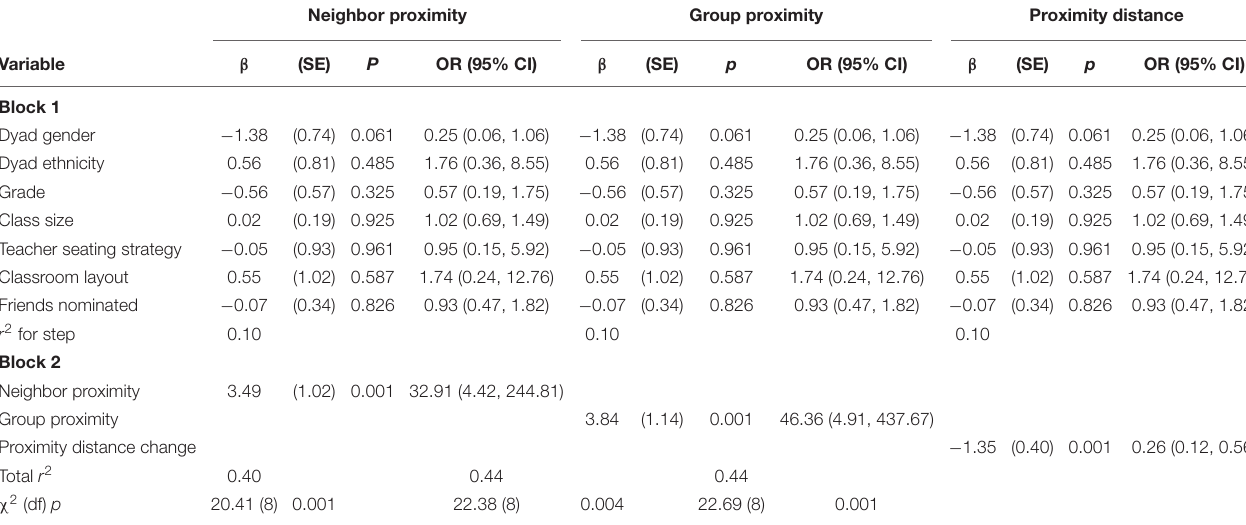
TABLE 4 | Longitudinal logistic regressions predicting new Time 2 reciprocated friendships from changes in classroom seating: One randomly selected dyad per student. Neighbor proximity Group